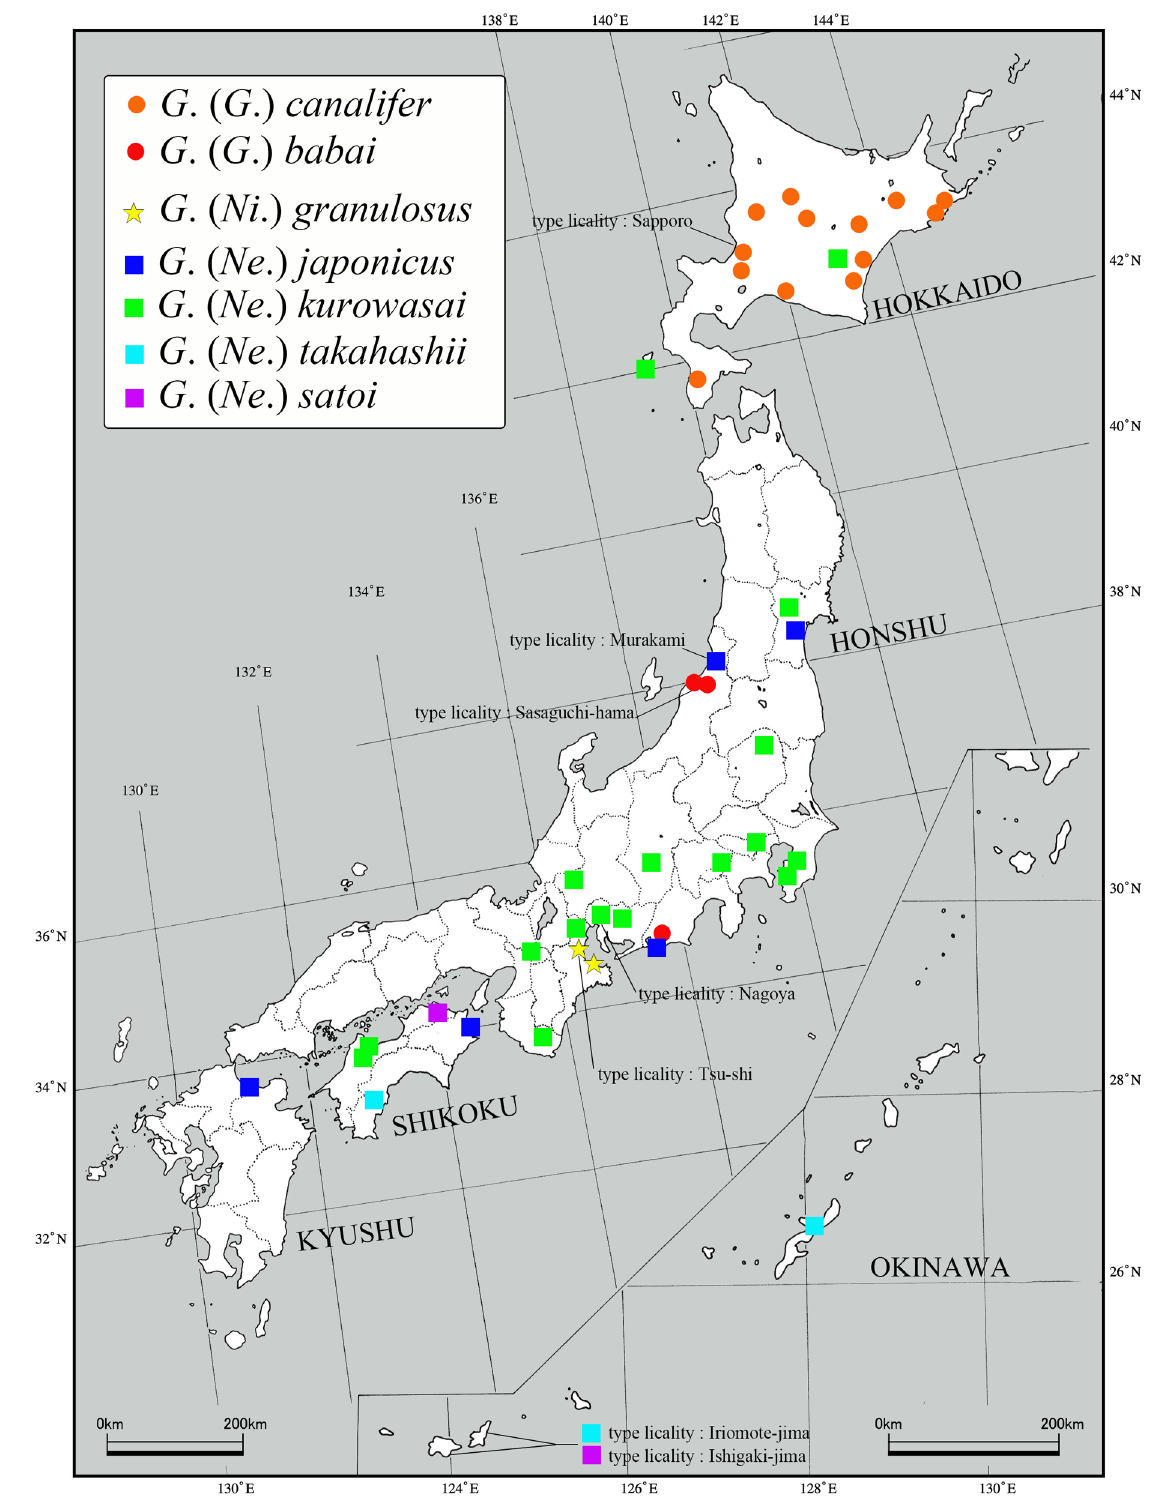
Fig. 13. Distribution map of Georissus spp. Russian localities for Georissus ( G .) canalifer Sharp, 1888 and G . ( Ne .) japonicus Satô, 1972 are